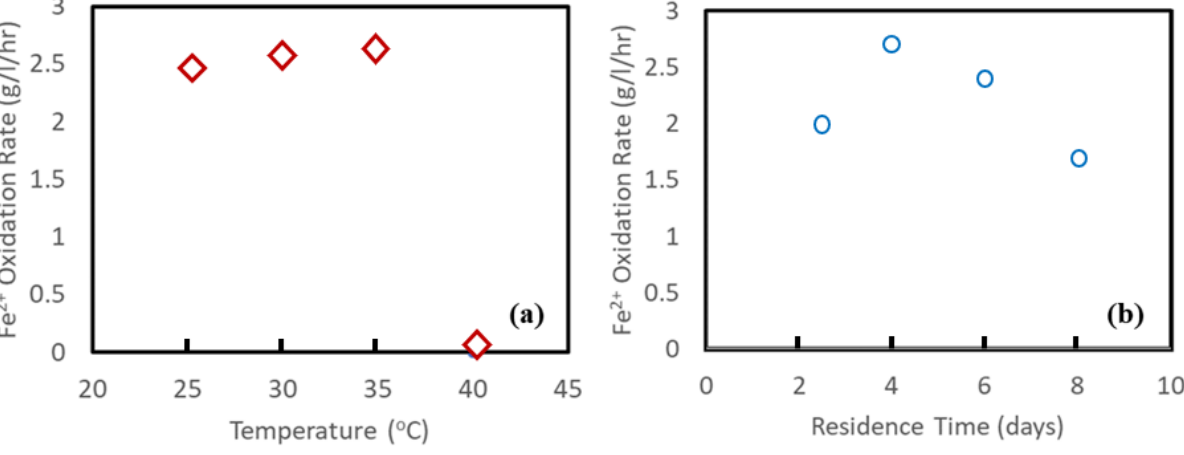
Figure 6. ( a ) Effect of temperature on ferrous ion production rate. ( b ) Comparison of residence time and ferrous ion oxidation rate.